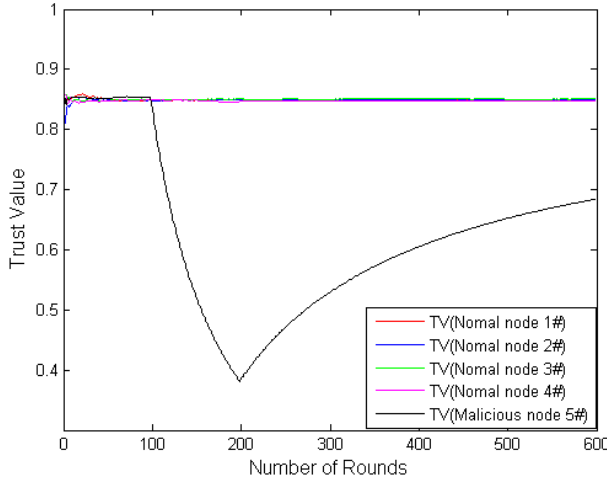
Figure 5. Trust value changes for interaction between nodes in a cluster.